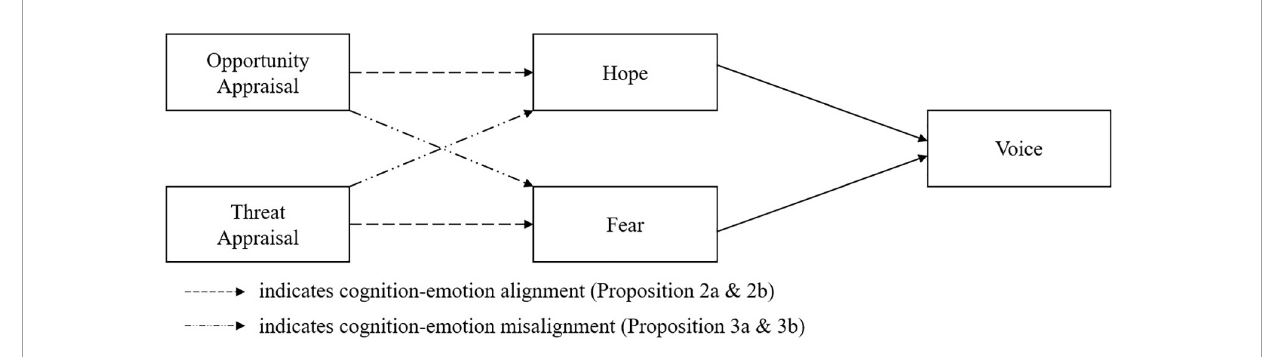
FIGURE2 The proposed conceptual